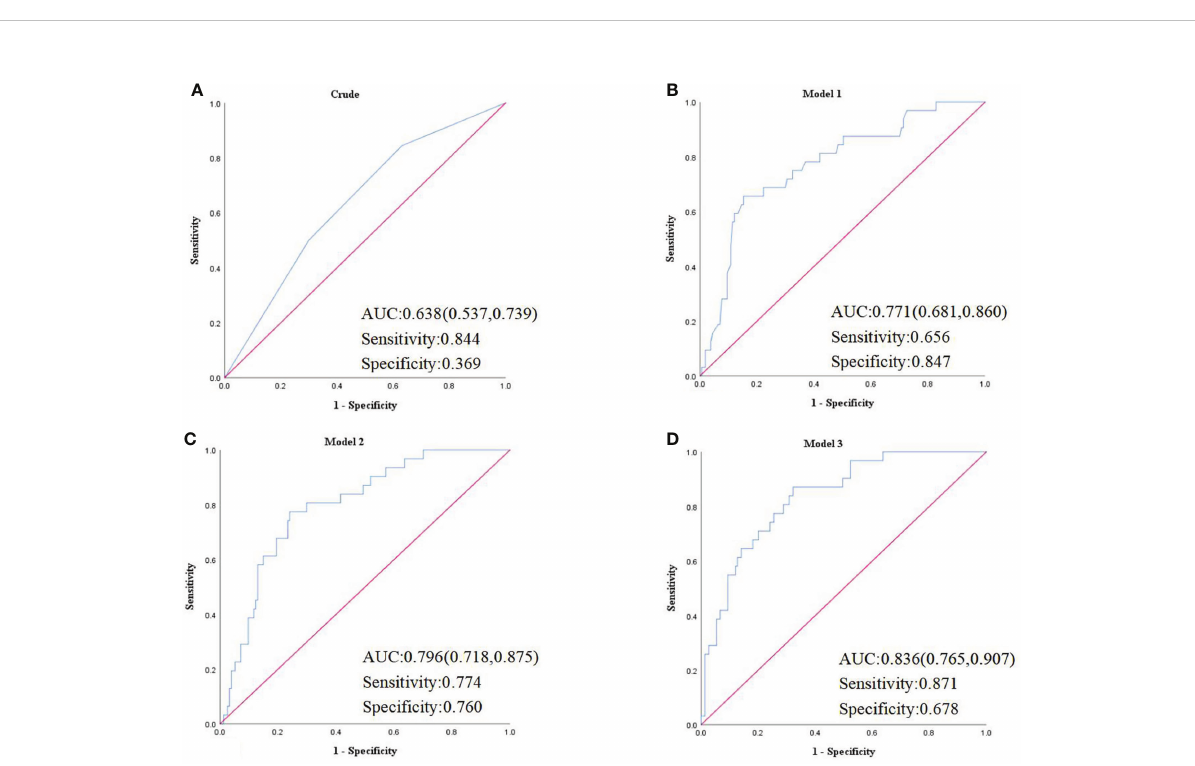
FIGURE 4 (A) Crude model was unadjusted. (B) Model 1 was adjusted for age and sex. (C) Model 2 was adjusted for the BMI, WC, HbA1C, TG, UACR in addition to the variables in model 1. (D) Model 3 was adjusted for duration of diabetes mellitus, history of hypertension, smoking history, drinking history, insulin therapy, RX with ACE-I/ARBs, hypolipidemic therapy in addition to the variables in model 2. AUC, area under the